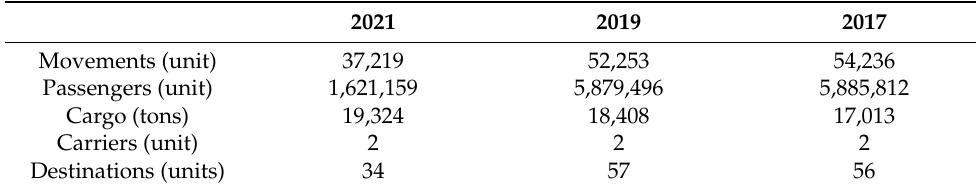
Table 1. Data on operations at Ciampino Airport [45–47].